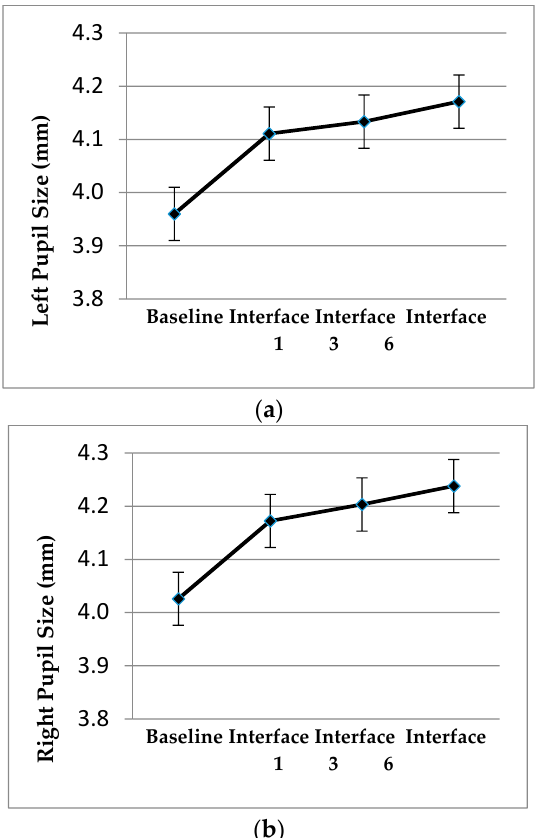
Figure 6. Mean and standard error of left and right pupil diameter according to the absence/presence of the interface and the interface design.